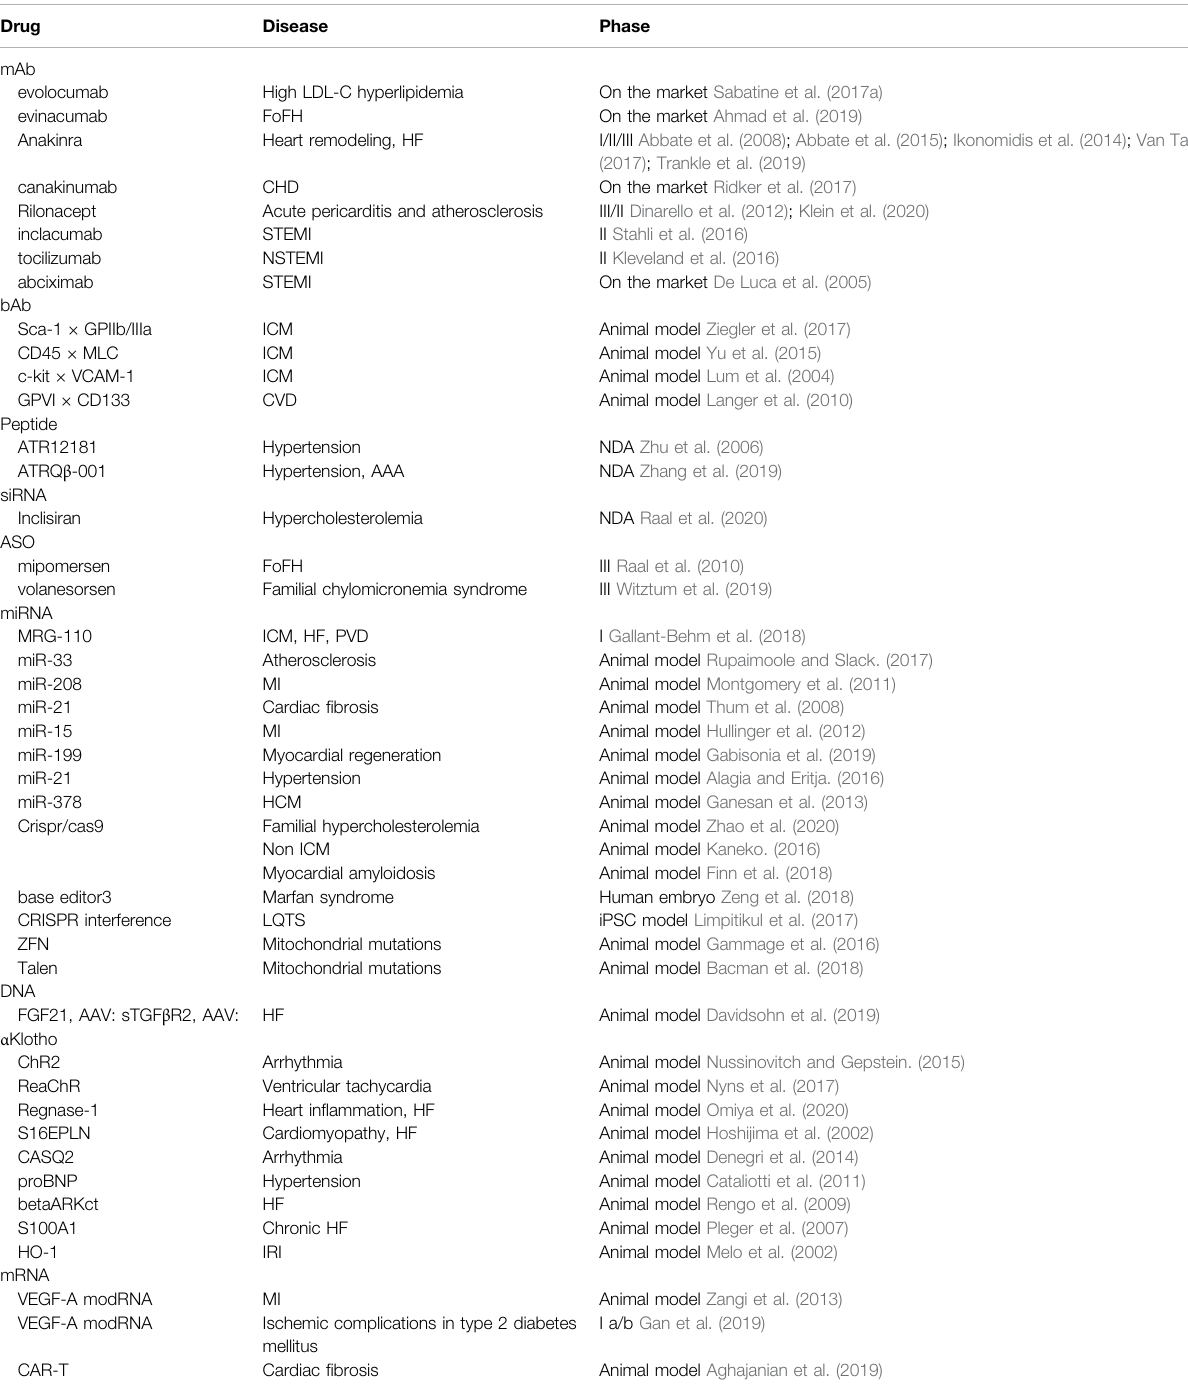
TABLE 3 | Targeted therapy in cardiovascular disease.